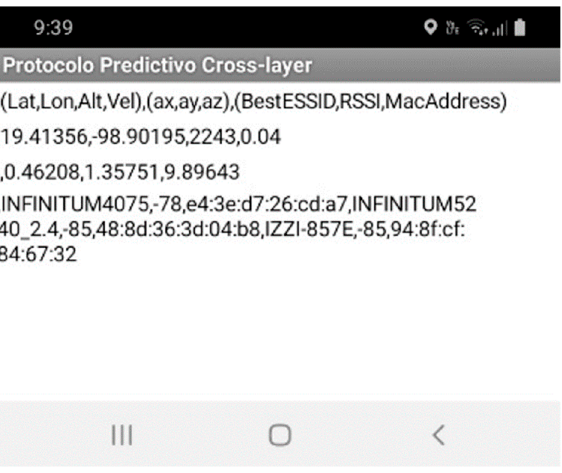
Figure 6. Screenshot smartphone.